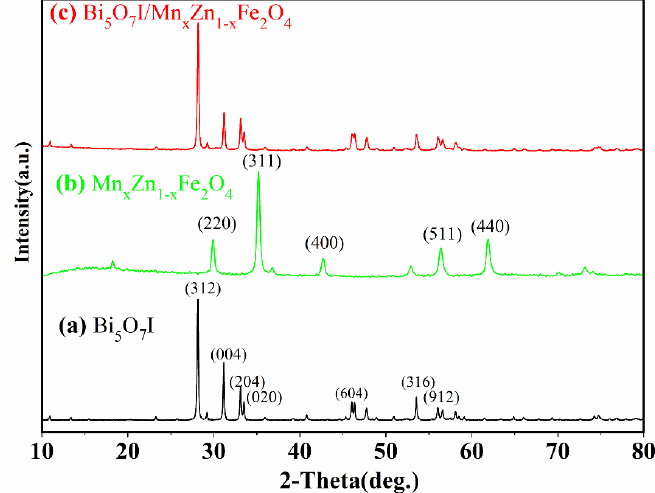
Figure 1. ( a ) X-ray diffraction (XRD) patterns of Bi 5 O 7 I; ( b ) XRD patterns of Mn x Zn 1 − x Fe 2 O 4 ; ( c ) XRD patterns of Bi 5 O 7 I/Mn x Zn 1 − x Fe 2 O 4 . patterns of Bi 5 O 7 I/Mn x Zn 1 − x Fe 2 O 4